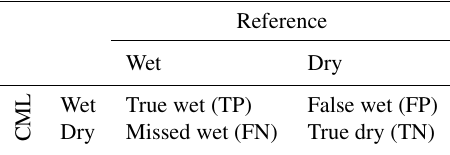
Table 1. Confusion matrix of CML and reference